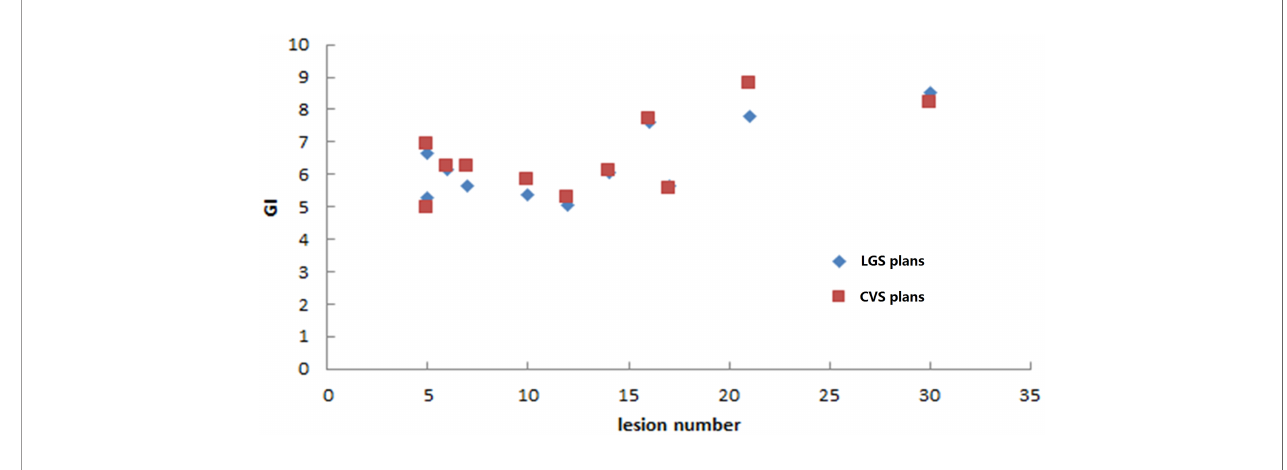
FIGURE 6 | Gradient index values of the two plans for the 11